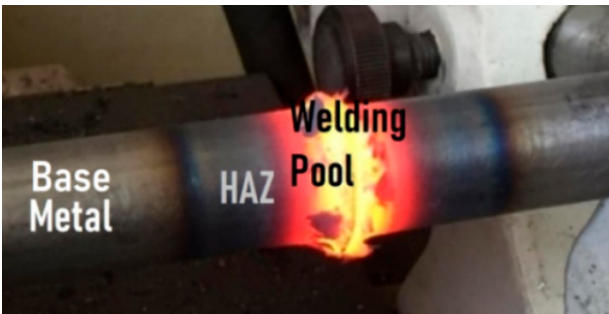
Figure 1. Air-cooled rotary inertia friction welded steel—steel rod.